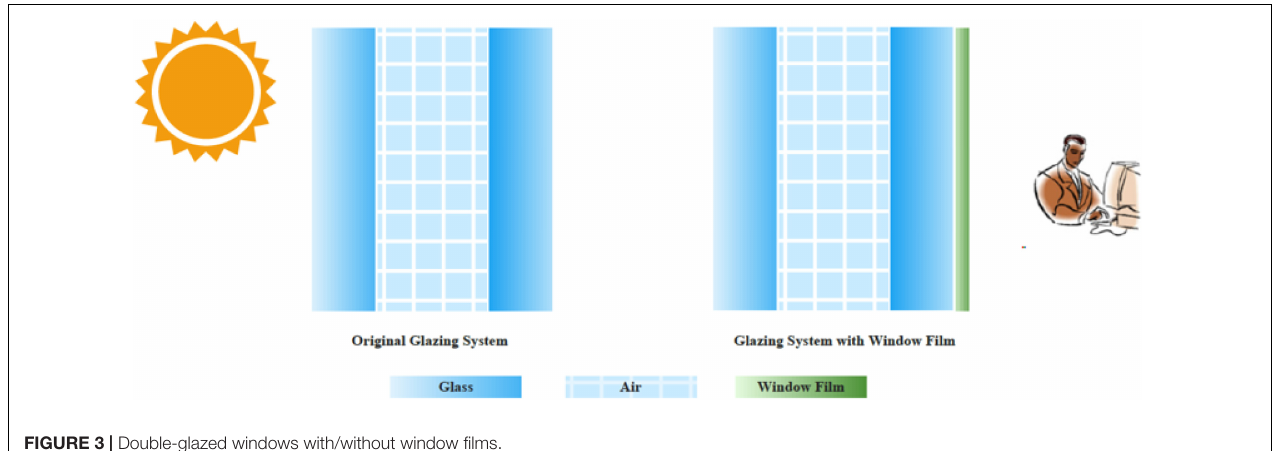
FIGURE 3 | Double-glazed windows with/without window films. TABLE 1 | Window film products of the Reflective company (Reflectiv, 2019).